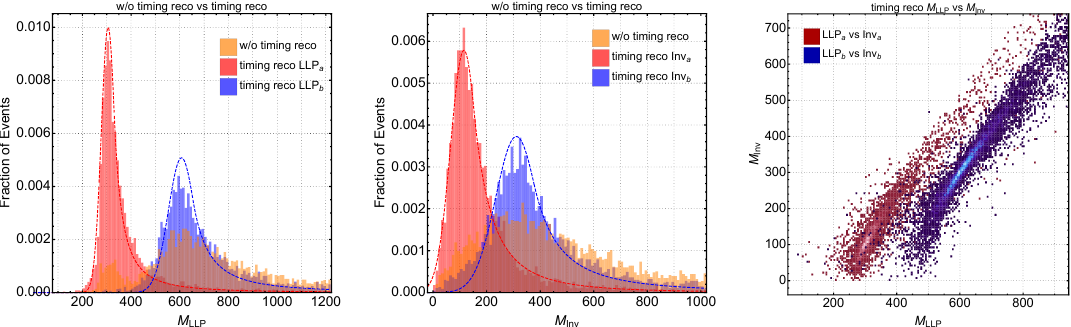
Figure 4 . Comparison with and without timing reconstruction. (Left) LLP mass reconstruction; (Center) Invisible particle mass reconstruction. Red and blue color indicate each decay chain of timing reconstruction result and the orange color is the without timing reconstruction result. The dashed lines are the (cid:12)tted curves of Crystal Ball probability distribution function as corresponds with the values in table 2. (Right) Invisible mass vs. LLP mass for each decay chain. All histograms were (cid:12)lled with 10 k events unless otherwise noted.